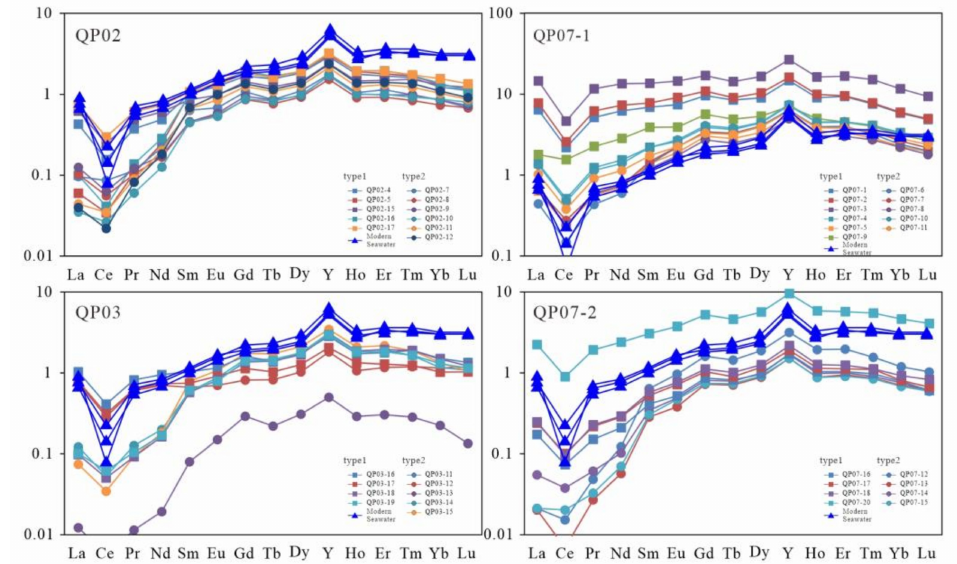
Figure 5. PAAS-normalized REE + Y pattern of all apatite types in the phosphate samples (Y inserted between Dy and Ho according to its ionic radius, REE of modern seawater multiplied by 10 7